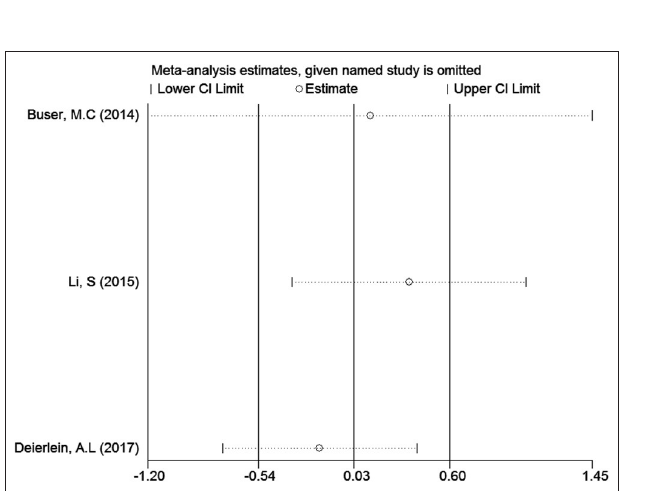
FIGURE 7 | Sensitivity analysis of TCS exposure during childhood and children’s BMI.